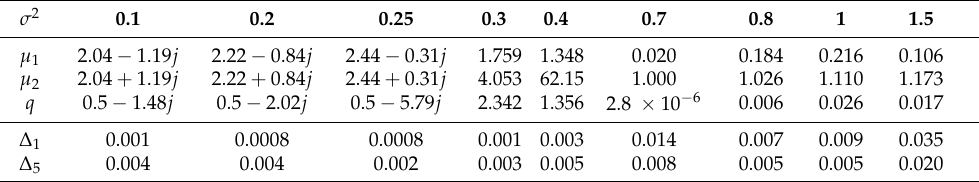
Table 3. Values of parameters µ 1 , µ 2 , and q of the hyperexponential approximation obtained for lognormal distribution function for various values of its parameter σ 2 (except values 0.4 < σ 2 < 0.7), and corresponding Kolmogorov distances ∆ for the main